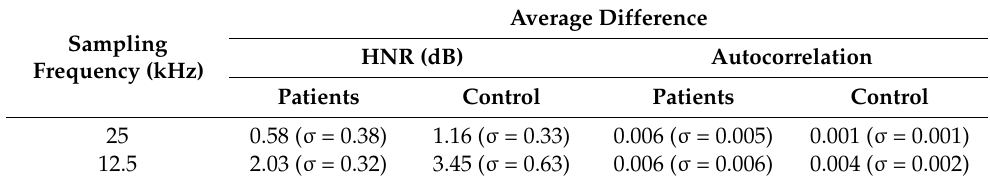
Table 2. HNR and Autocorrelation average differences as a function of sampling frequency.